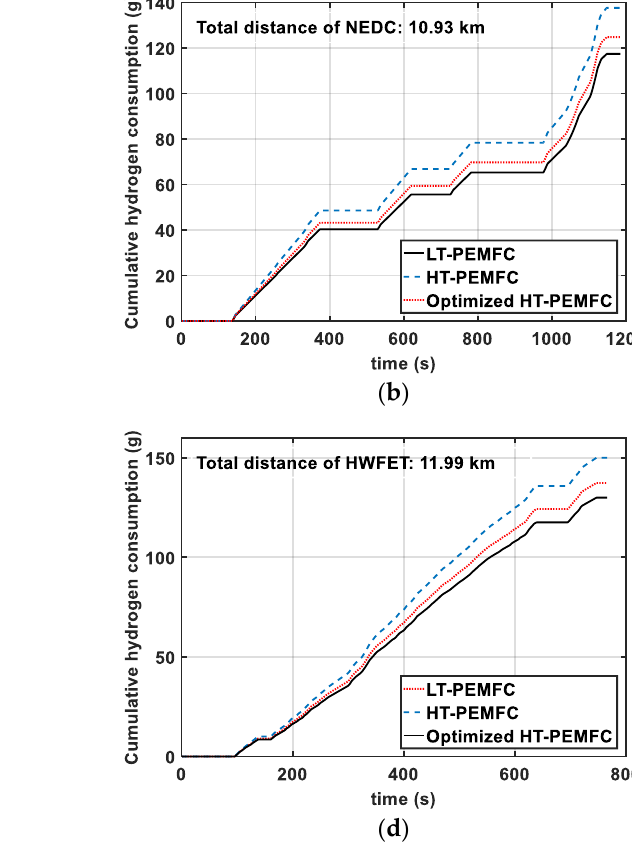
Figure 9. Comparison of cumulative hydrogen consumption under different driving cycles: ( a ) CCDC; ( b ) NEDC; ( c ) UDDS; ( d ) HWFET. Table 3. 100 km hydrogen consumption (g) under different driving